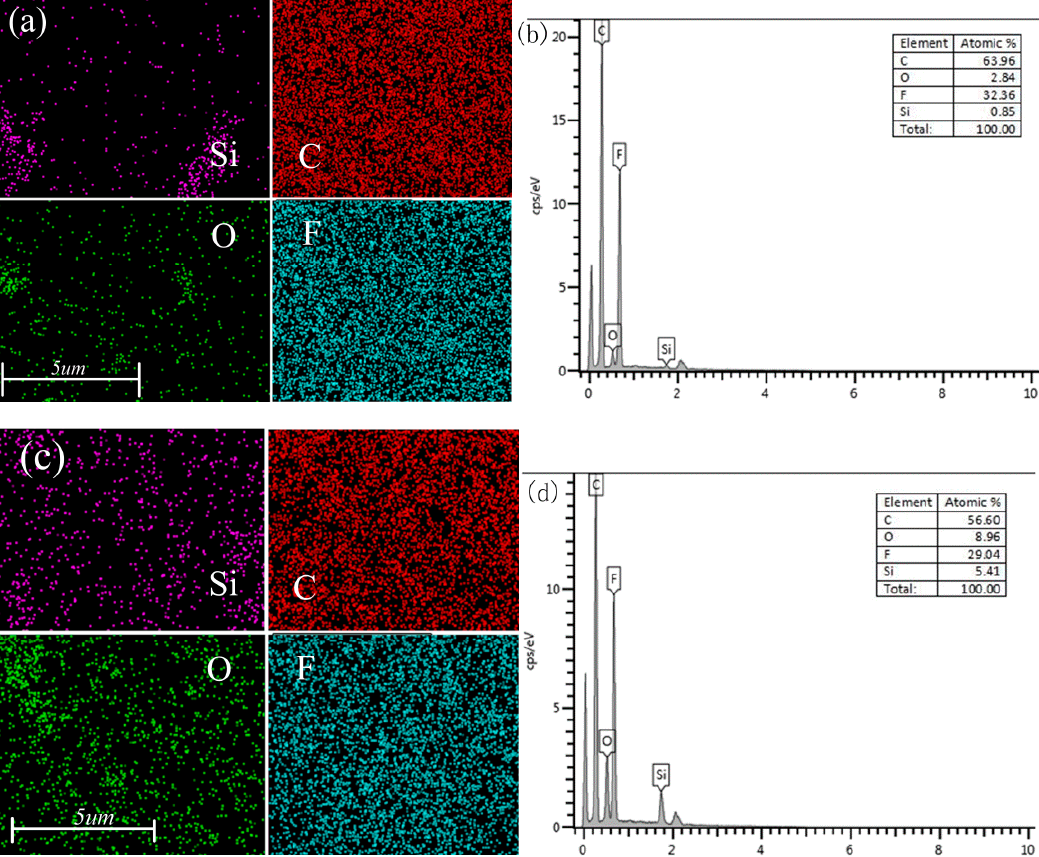
Figure 10. EDS of CB/SiO 2 /PVDF composite film (CB content 2 wt.%): ( a ) elemental mapping for 2 wt.% CB/1 wt.% SiO 2 /PVDF; ( b ) EDS spectrum of 2 wt.% CB/1 wt.% SiO 2 /PVDF; ( c ) elemental mapping for 2 wt.% CB/6 wt.% SiO 2 /PVDF; ( d ) EDS spectrum of 2 wt.% CB/6 wt.% SiO 2 /PVDF.